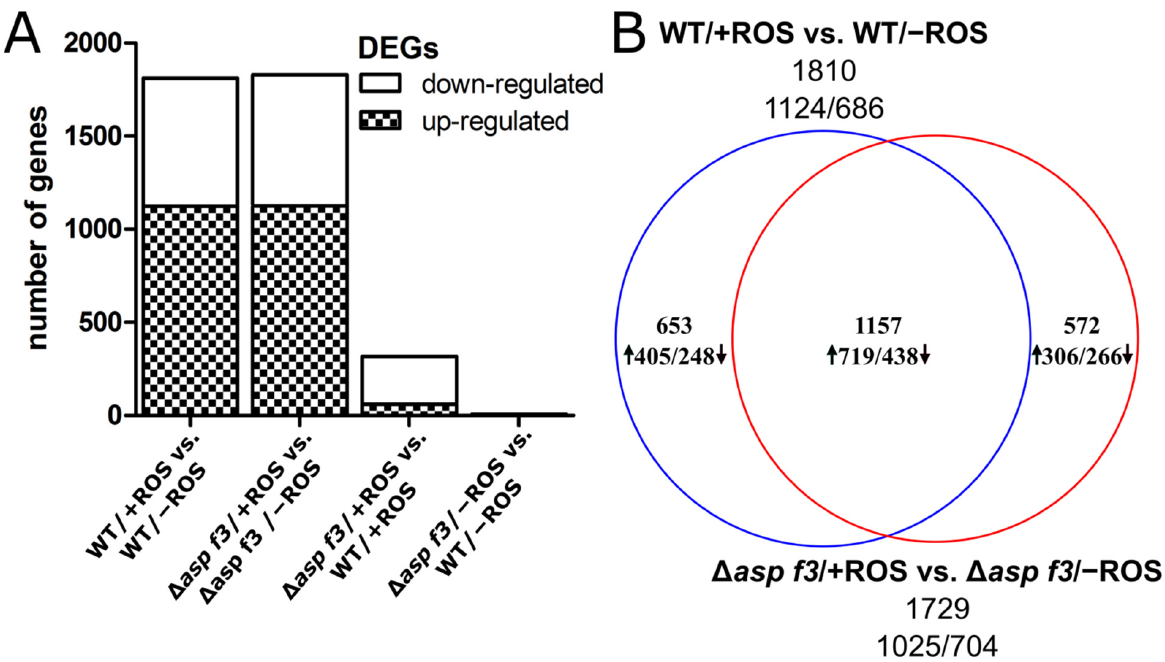
Figure 2. Reactive oxygen species dependent gene expression in Aspergillus fumigatus wild type (WT) and hyphae lacking Asp f3 ( Δ asp f3 ). ( A ): Comparison of the total number of differentially expressed genes (DEGs) and the direction of their regulation between strains and conditions. ( B ): Venn-diagram of DEGs in the transcriptomes of the WT and Δ asp f3 during ROS exposure. Given numbers represent the total number of DEGs. Arrows pointing up- or downwards indicate the direction of regulation.